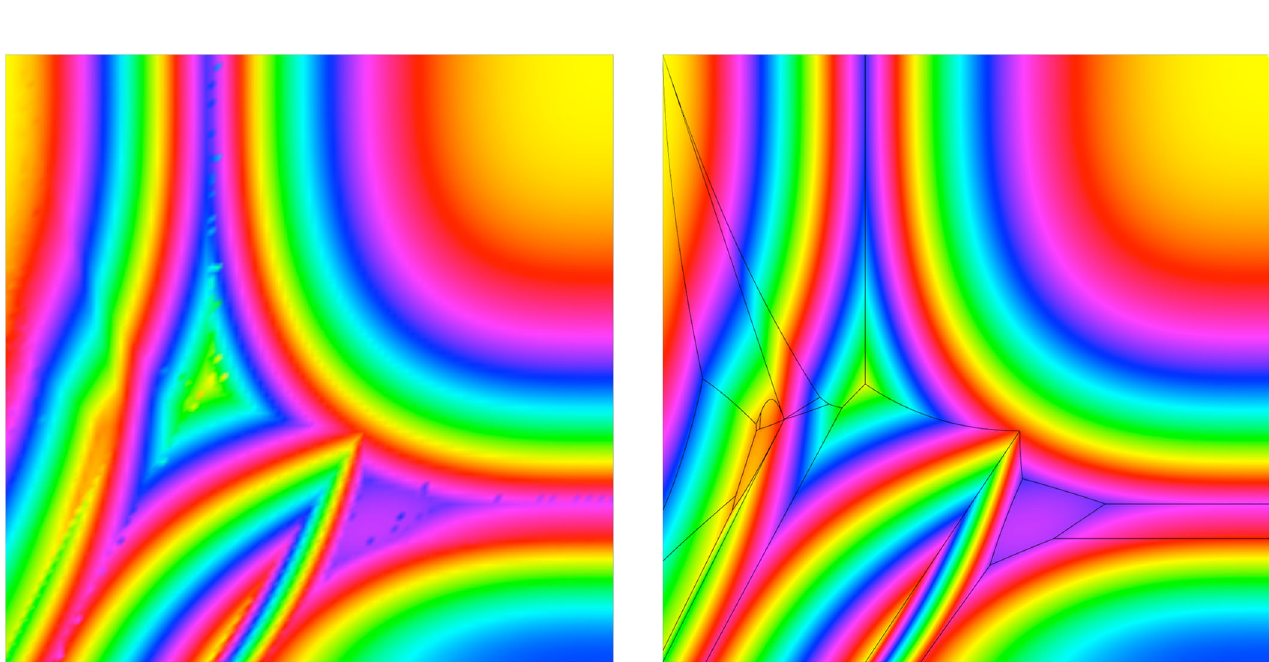
FIG. 13 Contours of optimal packing density ϕ for the 423 family, numeric (left) versus analytic (right). The color gradient {blue, magenta, red, yellow, green, cyan, and blue} represents the ϕ gradient f ϕ − 3 ϕ þ 2 ; ϕ þ 3 ; yellow contours occur at ϕ ¼ f 8 60 60 g